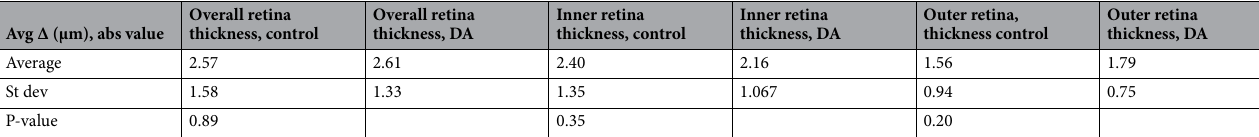
Table 3. Absolute values of average change in thickness, standard deviations, and p-values for overall, inner, and outer retinal layers between control and dark adapted (DA) eyes respectively.